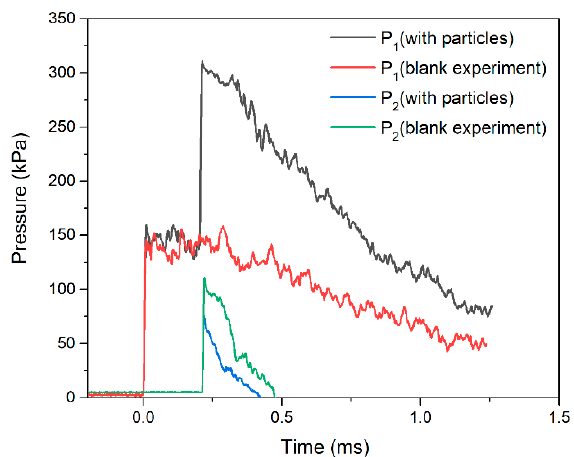
Figure 5. Comparison of pressure in the blank experiment and the shock wave experiment with solid particles.